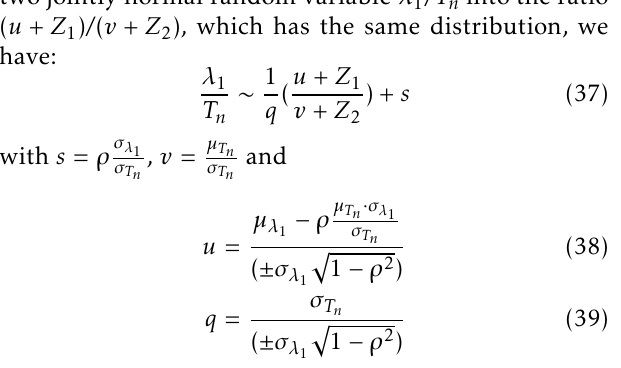
Table 1. The Empirical and Approximated value of the correlation coefficient ρ under H hypothesis for different values of { K, N } 0